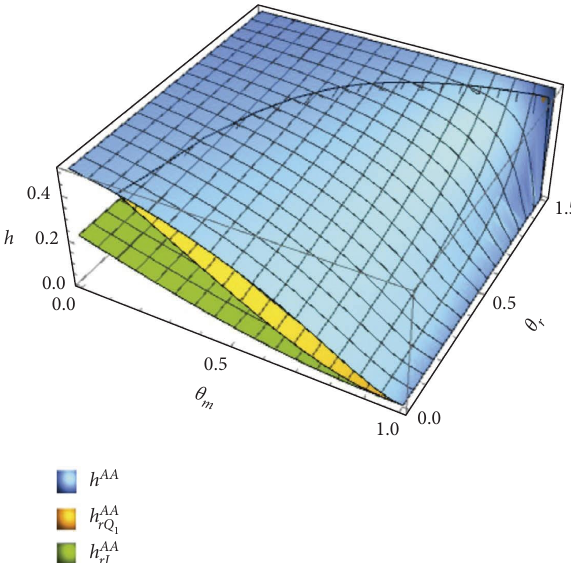
Figure 8: Tresholds of retailer altruism’s infuence on frst-period ordering quantities and inventories ( a � 1 , b � 0 . 5 , c � 0 . 2 , c � 1 )